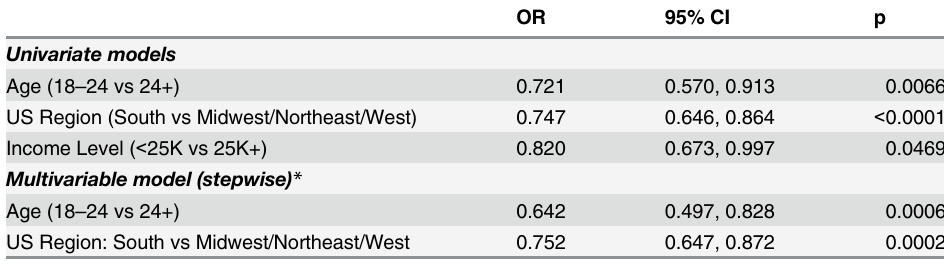
a Probable/Definitive PD diagnosis were: (a) less likely to have been in the 24+ age group and (b) less likely to be in non-South regions of the country (Table 3). Table 4 shows that there were significant differences (p < 0.0001) between definitive PD cases and probable PD cases with respect to the occurrence of four symptoms: (a) unusual firmness or hardened tissue under non-erect penis; (b) lump/bump, firmness/hardness affect- ing shape of erect penis; (c) development of a new or significant curve or bend of erect penis; and (d) indentation on one or both sides of erect penis, with definitive PD cases having a signif- icantly higher proportion of cases with the above-mentioned symptoms. With respect to PD treatment, 19.3% of definitive PD cases and 3.4% of probable PD cases had treatment that was specific for PD (p < 0.0001) (Table 3). Table 3. Predicting probable/definitive PD versus no PD diagnosis. OR